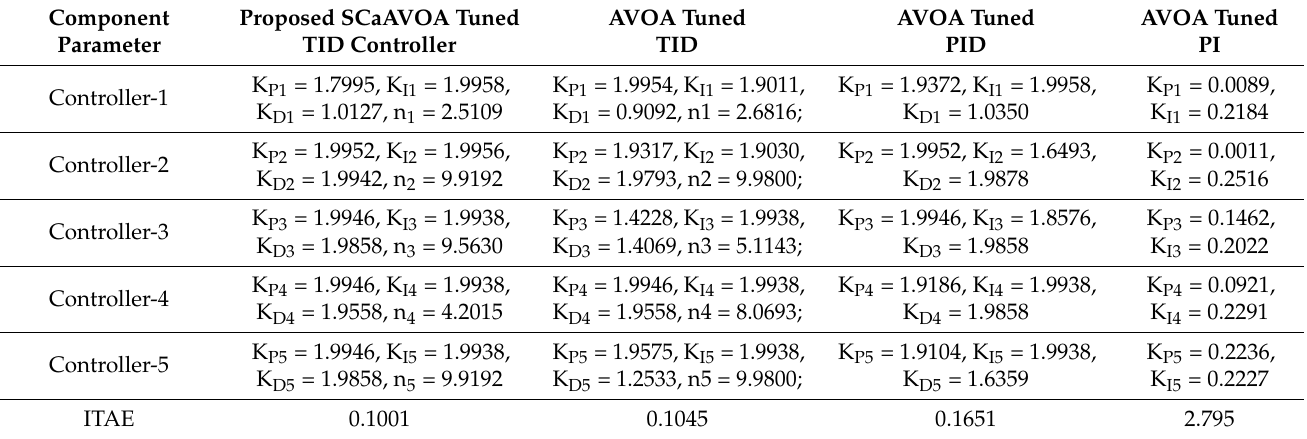
Table 5. Controller parameters for the five-area power system.